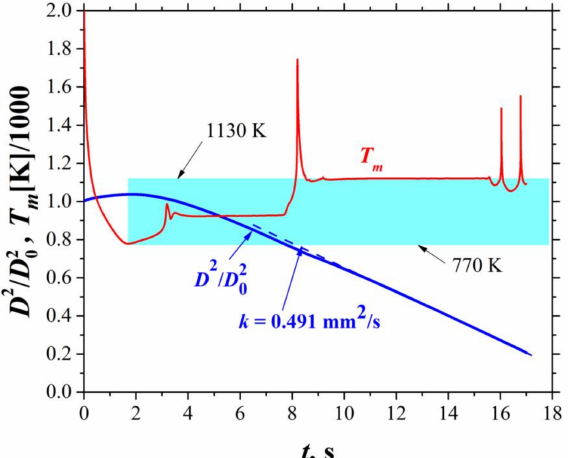
Figure 12. Calculated time histories of the maximum gas temperature, T m , and the normalized squared droplet diameter, D 2 / D 2 , at the forced ignition and combustion of the n-dodecane droplet 0 with D 0 = 2.8 mm and L = 0.53 cm in air at NPT conditions. The blue band envelopes the low- temperature flashes of cool and blue